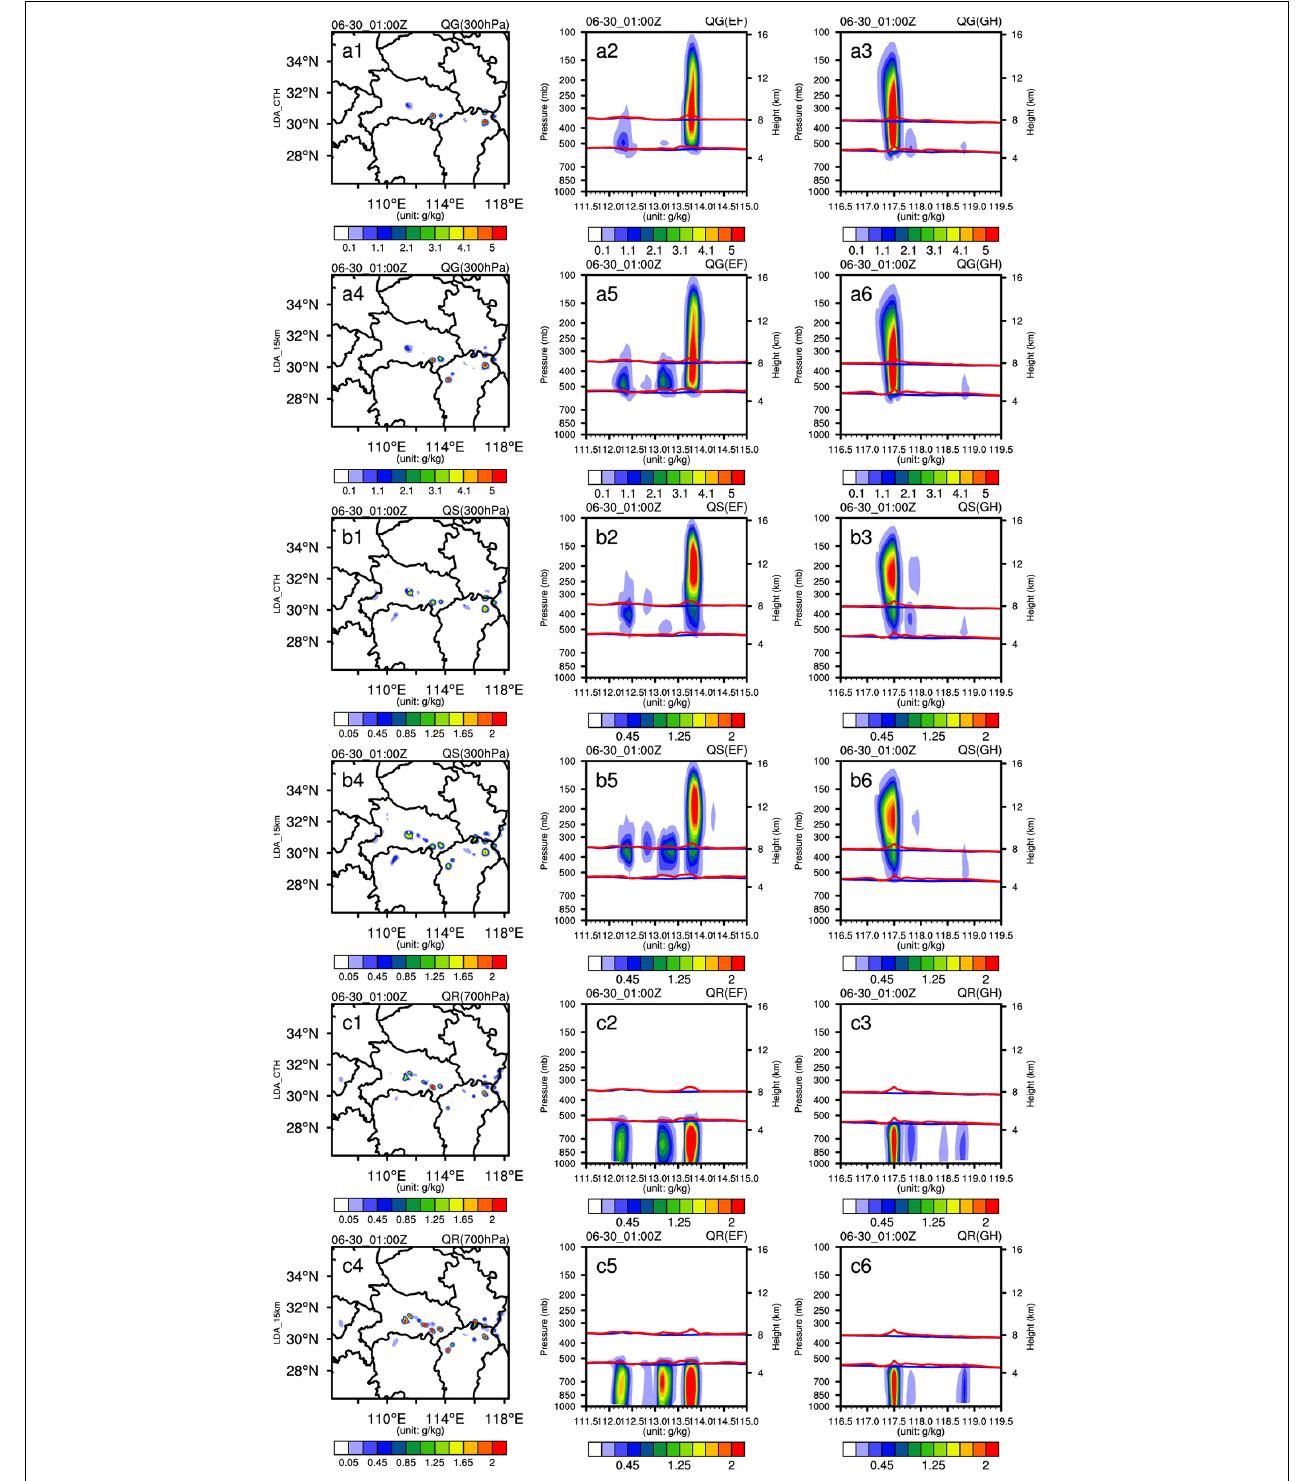
FIGURE 10 | The hydrometeor field differences at 0100 UTC on 30 June 2018 for the graupel mixing ratio (QG) (a1–a6) , snow mixing ratio (QS) (b1–b6) and rain water mixing ratio (QR) (c1–c6) between LDA_CTH and CTL (a1–a3,b1–b3, c1–c3) and between LDA_15km and CTL (a4–a6,b4–b6,c4–c6) . The first column shows the difference for QG at 300 hPa, QS at 300 hPa and QR at 700 hPa. The second column shows the cross sections along line EF, and the third column shows the cross sections along line GH.